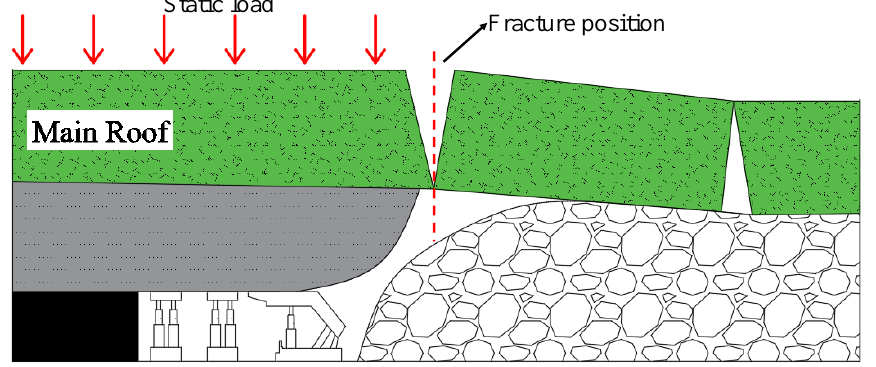
Figure 13. Top cutting position at the second stage.